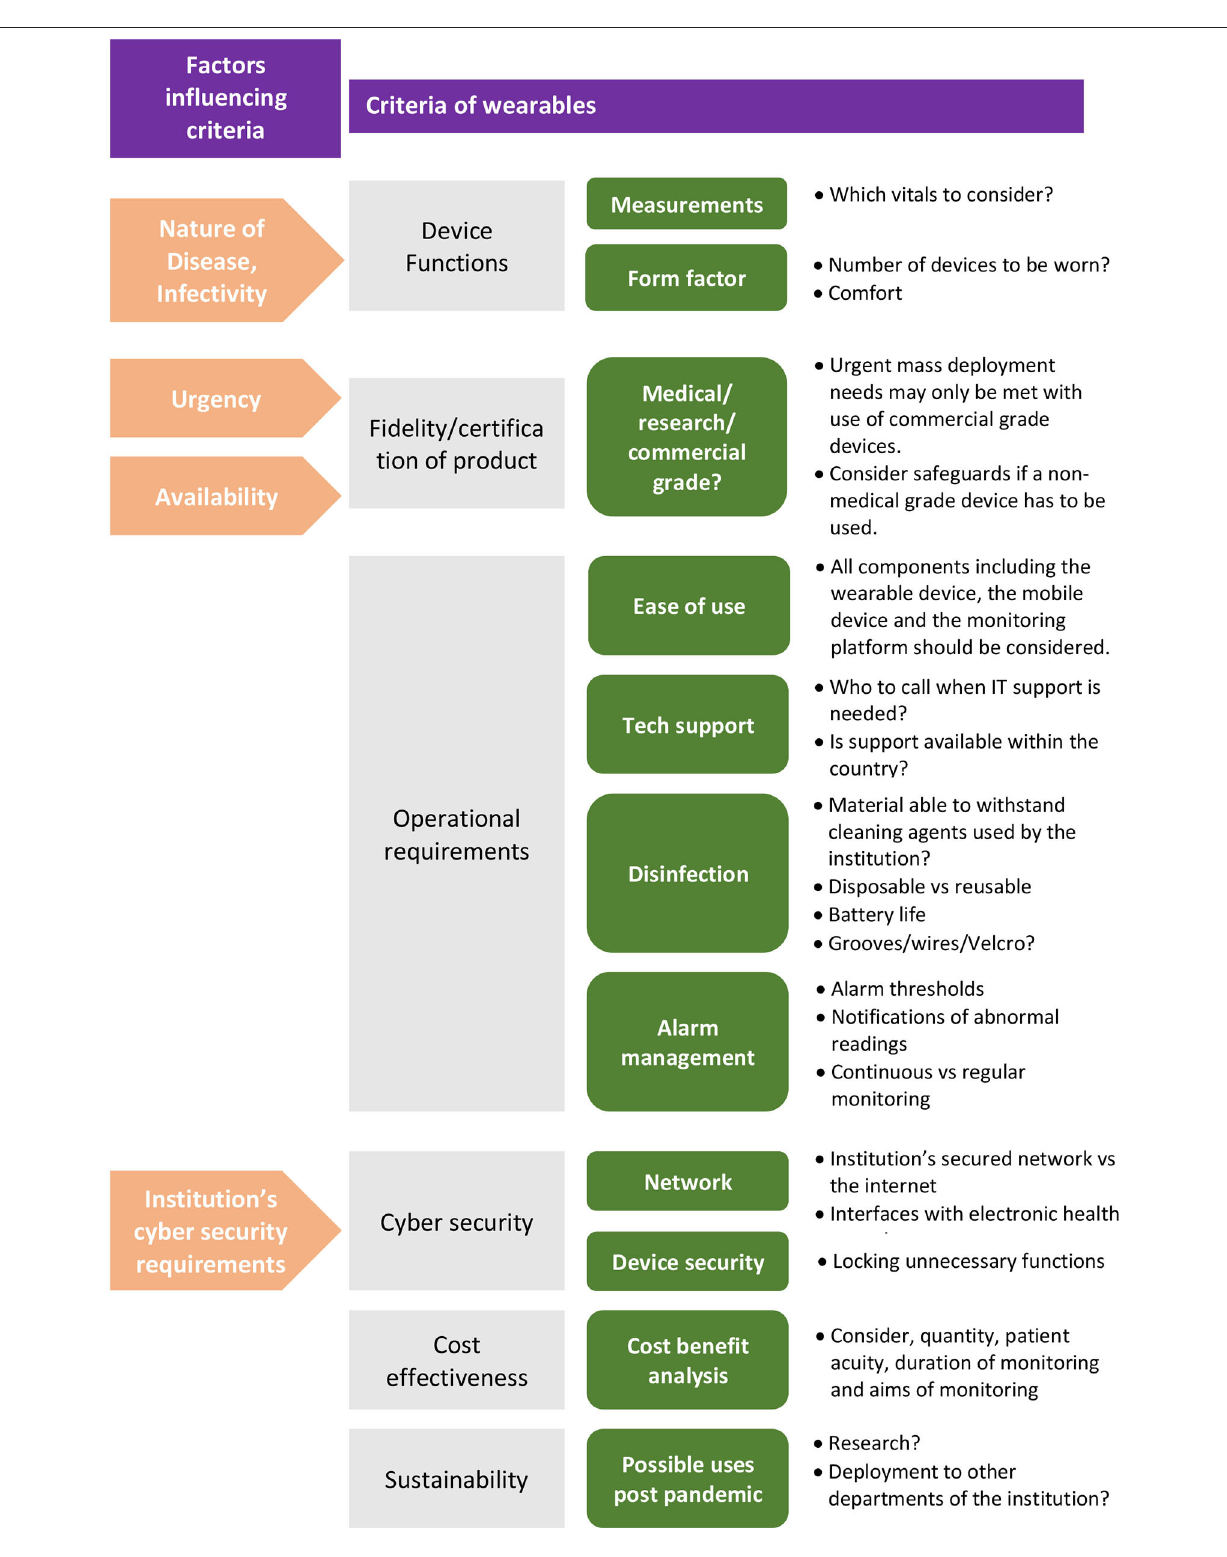
Frontiers in Digital Health |